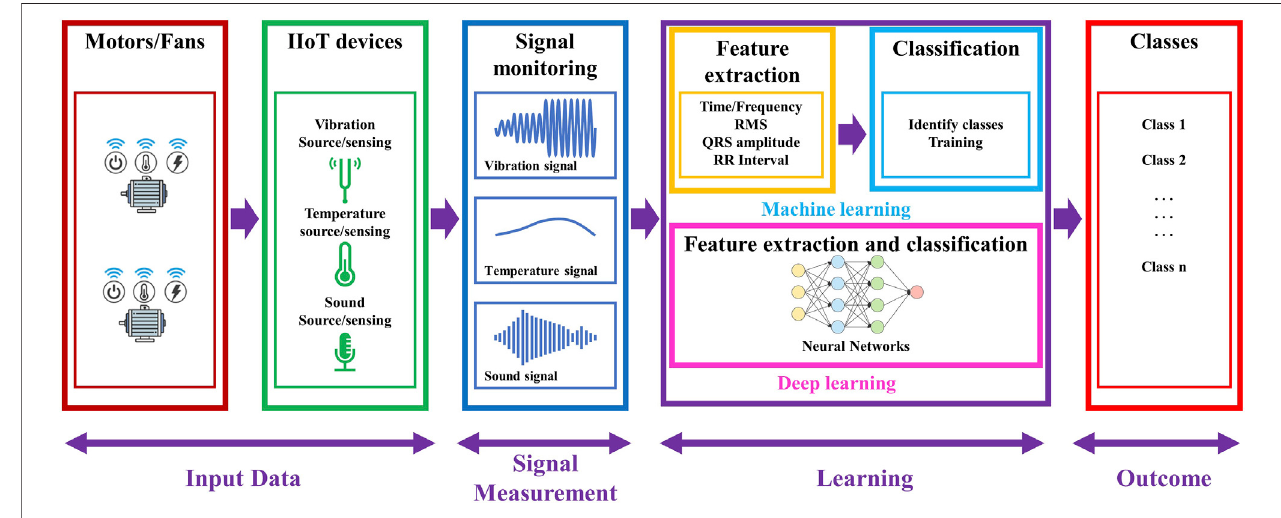
FIGURE 7 | Fusing the PdM application with